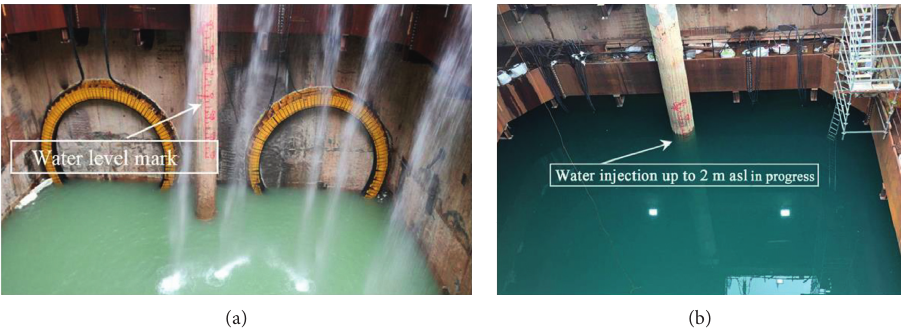
Figure 5: Water injection into the receiving shaft: (a) initiation of water injection and (b) water injection up to 2 m a.s.l. in